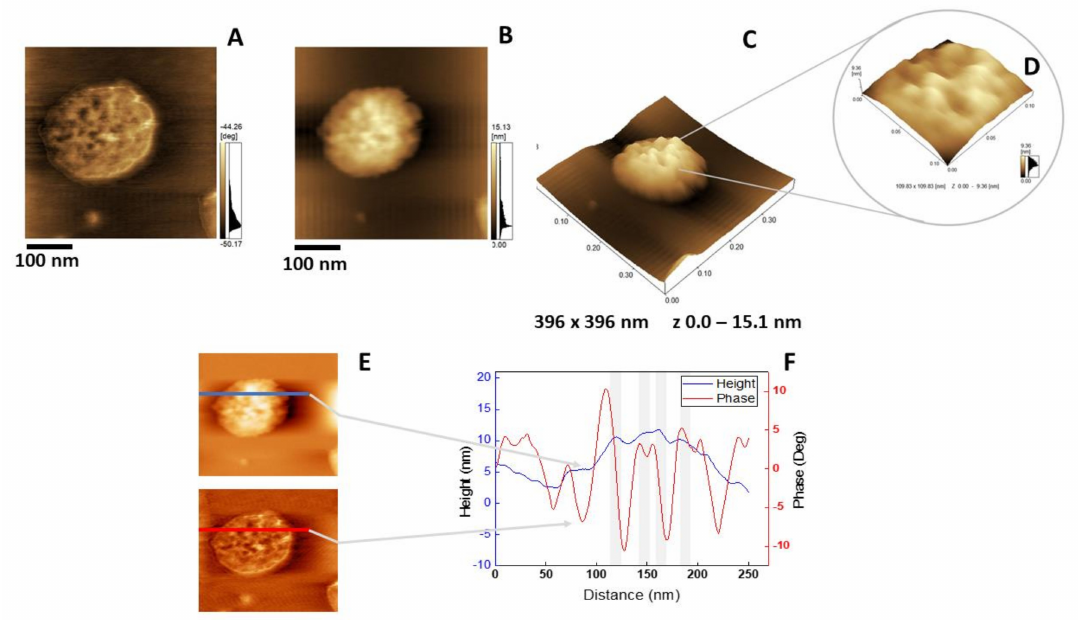
Figure 7. AFM analysis of 6:4:1 DPPC:Chol:DPPS proteoliposomes harboring AnxA6: ( A ) Phase image, ( B ) height image, ( C ) 3D topographic profile, and ( D ) magnification of a 109.83 × 109.83 nm 2 surface area showing protein domains; ( E and F ) phase and height line analysis (blue and red lines)